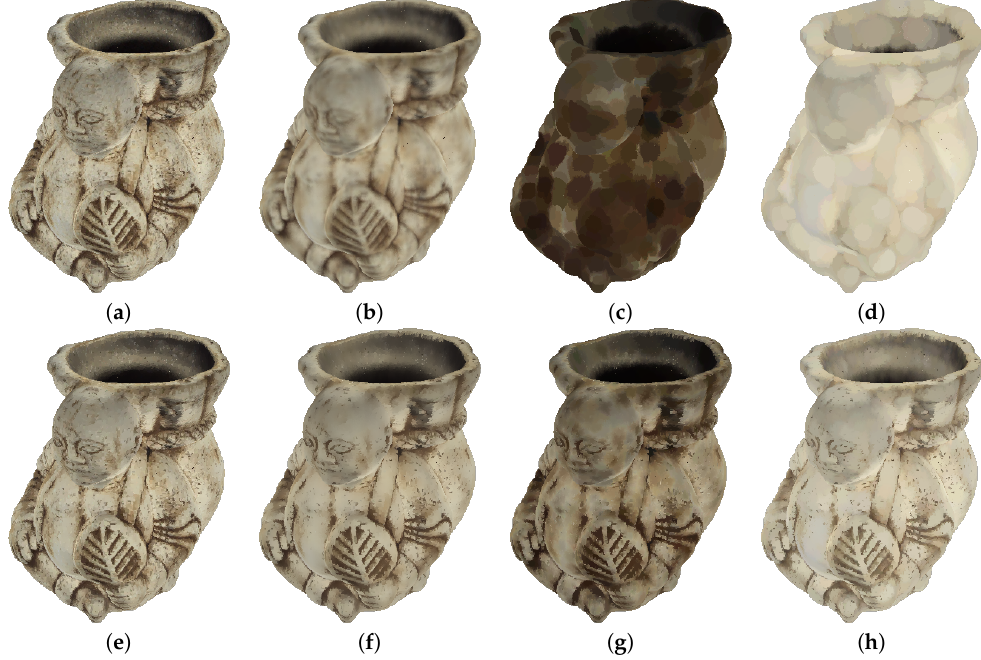
Figure 4. Filtering of a colored point cloud with the NLD , NLD and NLA operators with k = 8. ( a ) Original; ( b ) NLA w = 1; ( c ) NLE w = 1; ( d ) NLD w = 1; ( e ) NLA 0 w (cid:54) = 1; ( f ) NLA w (cid:54) = 1; ( g ) NLE w (cid:54) = 1; ( h ) NLD w (cid:54) = 1. ( b – d , g , h ) The results after 20 iterations. ( e , f ) The results after 200 iterations (see Section